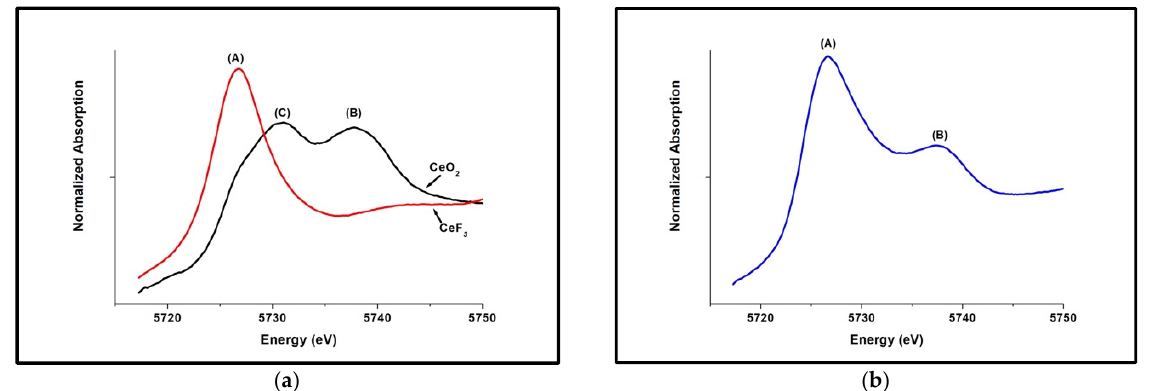
Figure 1. XANES spectrum for ( a ) standards of Ce(IV) and Ce(III) compounds, ( b ) Na 2 O·2B 2 O 3 glass melted with 0.05 mols of CeO 2 .